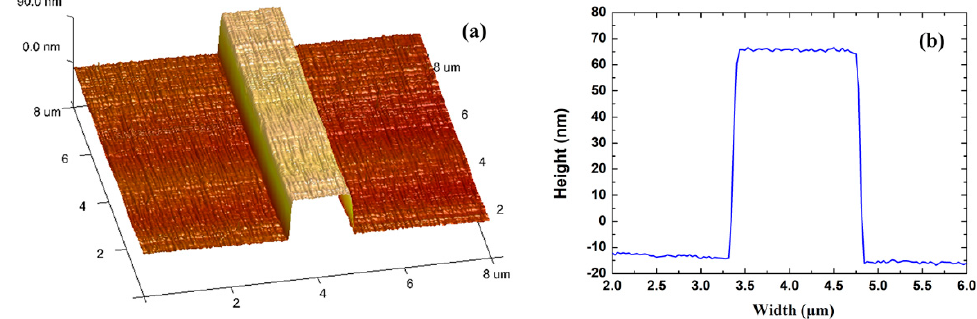
Figure 11. ( a ) areal scan, and ( b ) linear scan of an Au stripe by atomic force microscopy after oxygen plasma cleaning, but before application, of the SU-8 upper cladding.